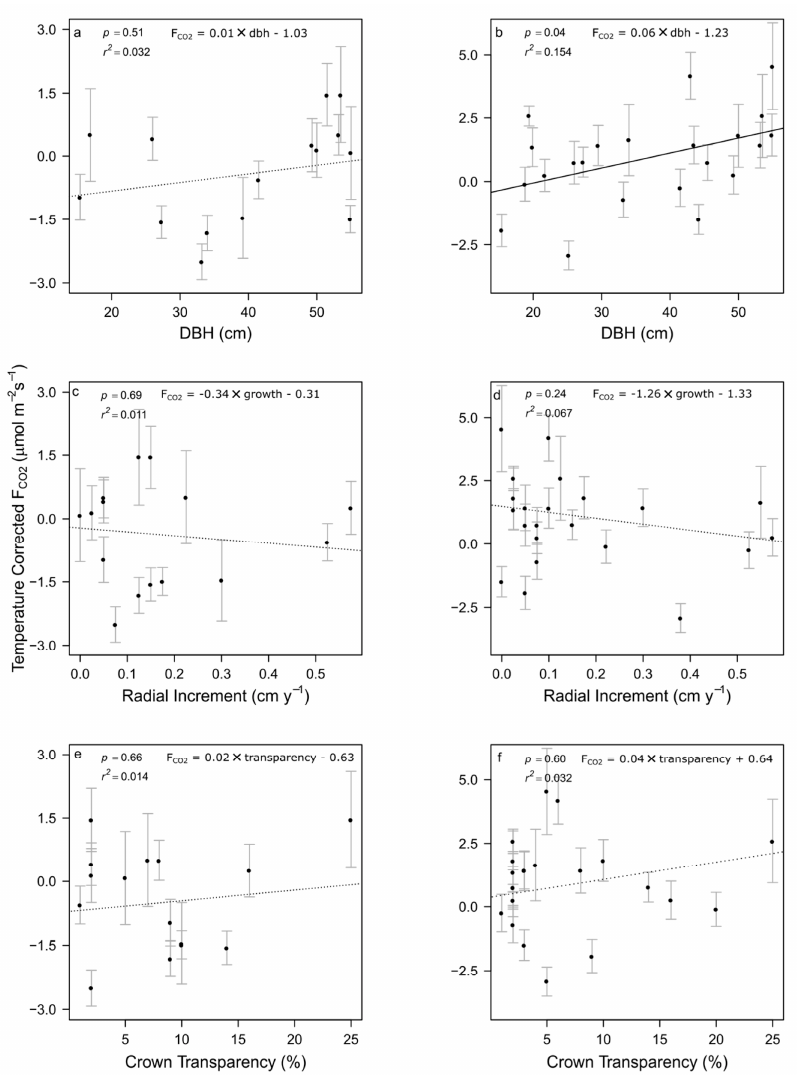
Figure 5. Relationships between individual tree characteristics and temperature-corrected soil CO 2 efflux. Error bars represent standard error (n = 6) in each individual tree’s root zone flux. Significant variation was detected among individual tree root zones both before (panels ( a , c , e )) and after (panels ( b , d , f )) wetting ( p dry and p wet < 0.001). Post-rain variation in soil root zone fluxes was significantly related to tree dbh (solid regression line) but not to other variables (dotted regression lines).